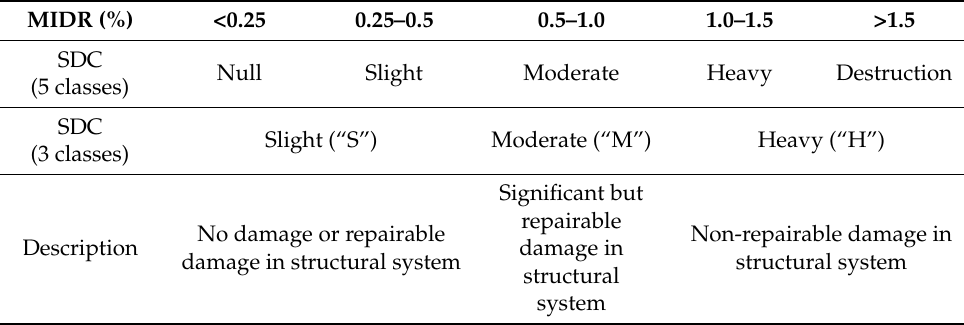
Table 1. Definition of 3 or 5 SDCs according to MIDR seismic damage